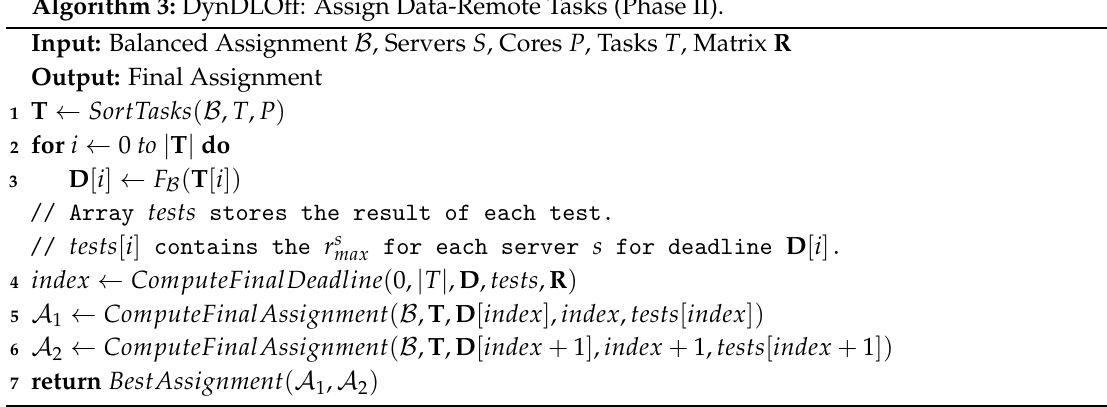
Figure 4. Key steps of Phase II (the assignment is the best when | T rem | is 1). Algorithm 3: DynDLOff: Assign Data-Remote Tasks (Phase